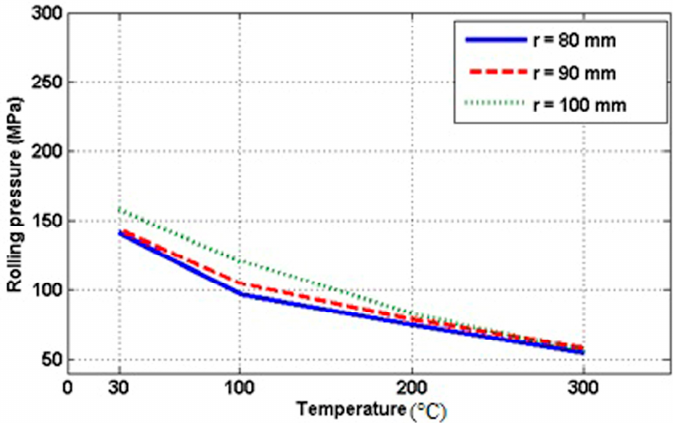
Figure 10. Maximum stress exerted on the bimetal strips with 10% of thickness reduction ratio at different roll diameters and rolling temperatures.